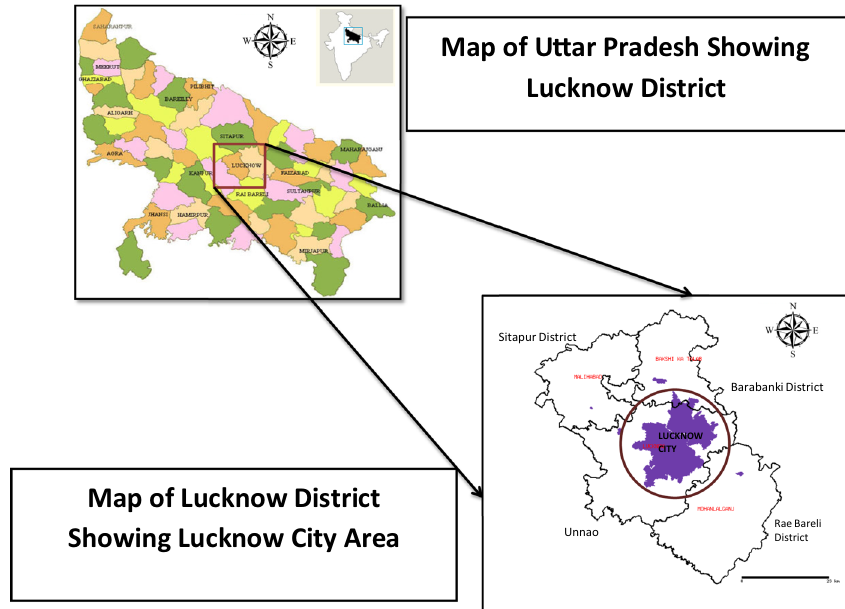
Fig. 1 Location map of study